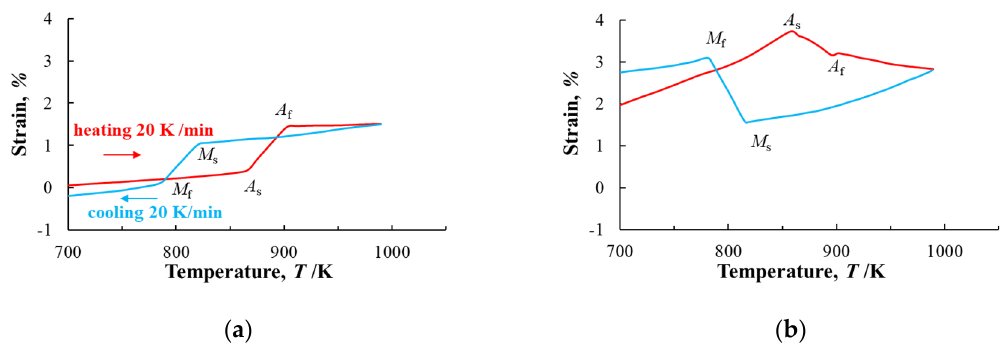
Figure 1. Strain as a function of temperature during thermo ‐ mechanical test of equiatomic TiPd alloy. ( a ) 90 and ( b ) 0 degrees sample. ( a ) 90 and ( b ) 0 degrees